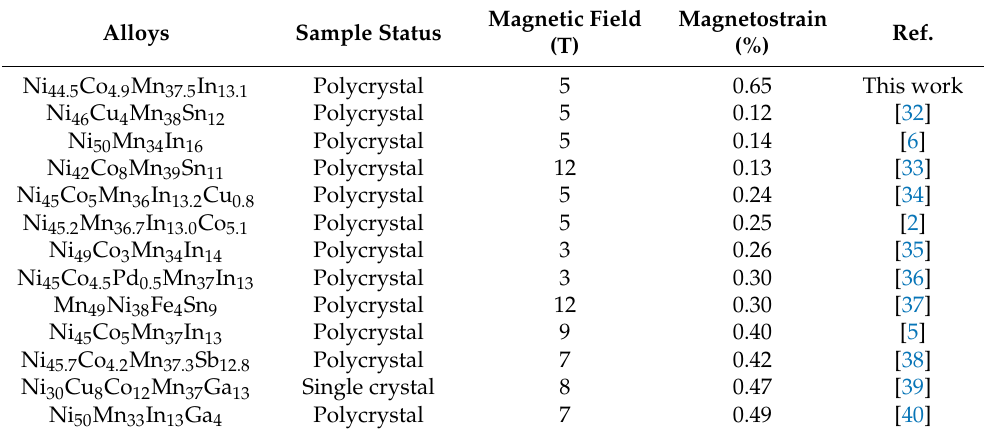
Table 2. Comparison of spontaneous magnetostrain between the present alloy and other Ni-Mn-based alloys reported in the literature. Alloys Sample Status